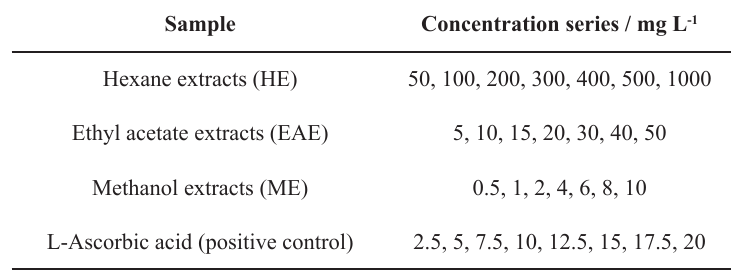
Table 1: Concentration series prepared for DPPH